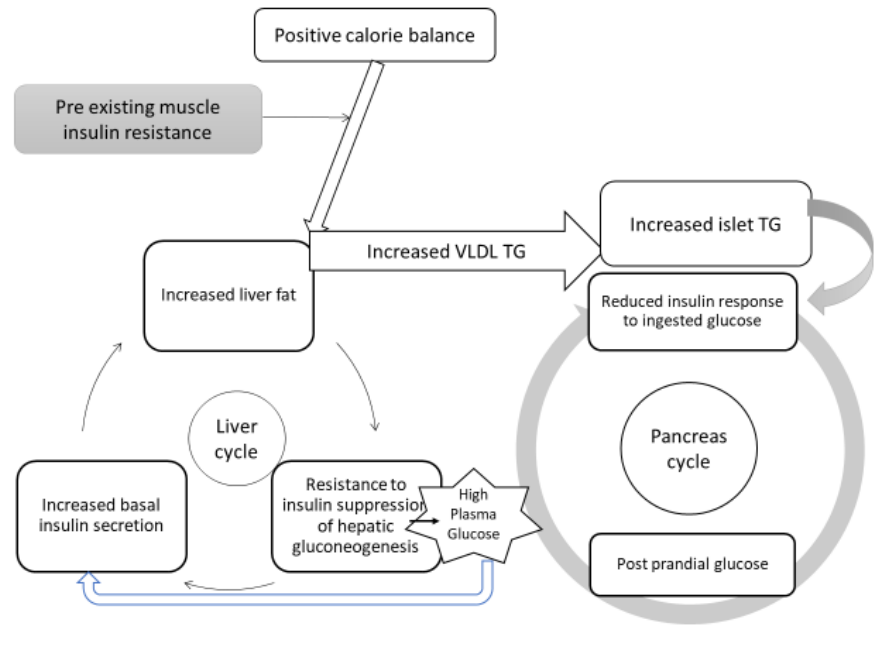
Figure 1: The twin cycle hypothesis of the aetiology of T2DM -adapted from Taylor R, 2013